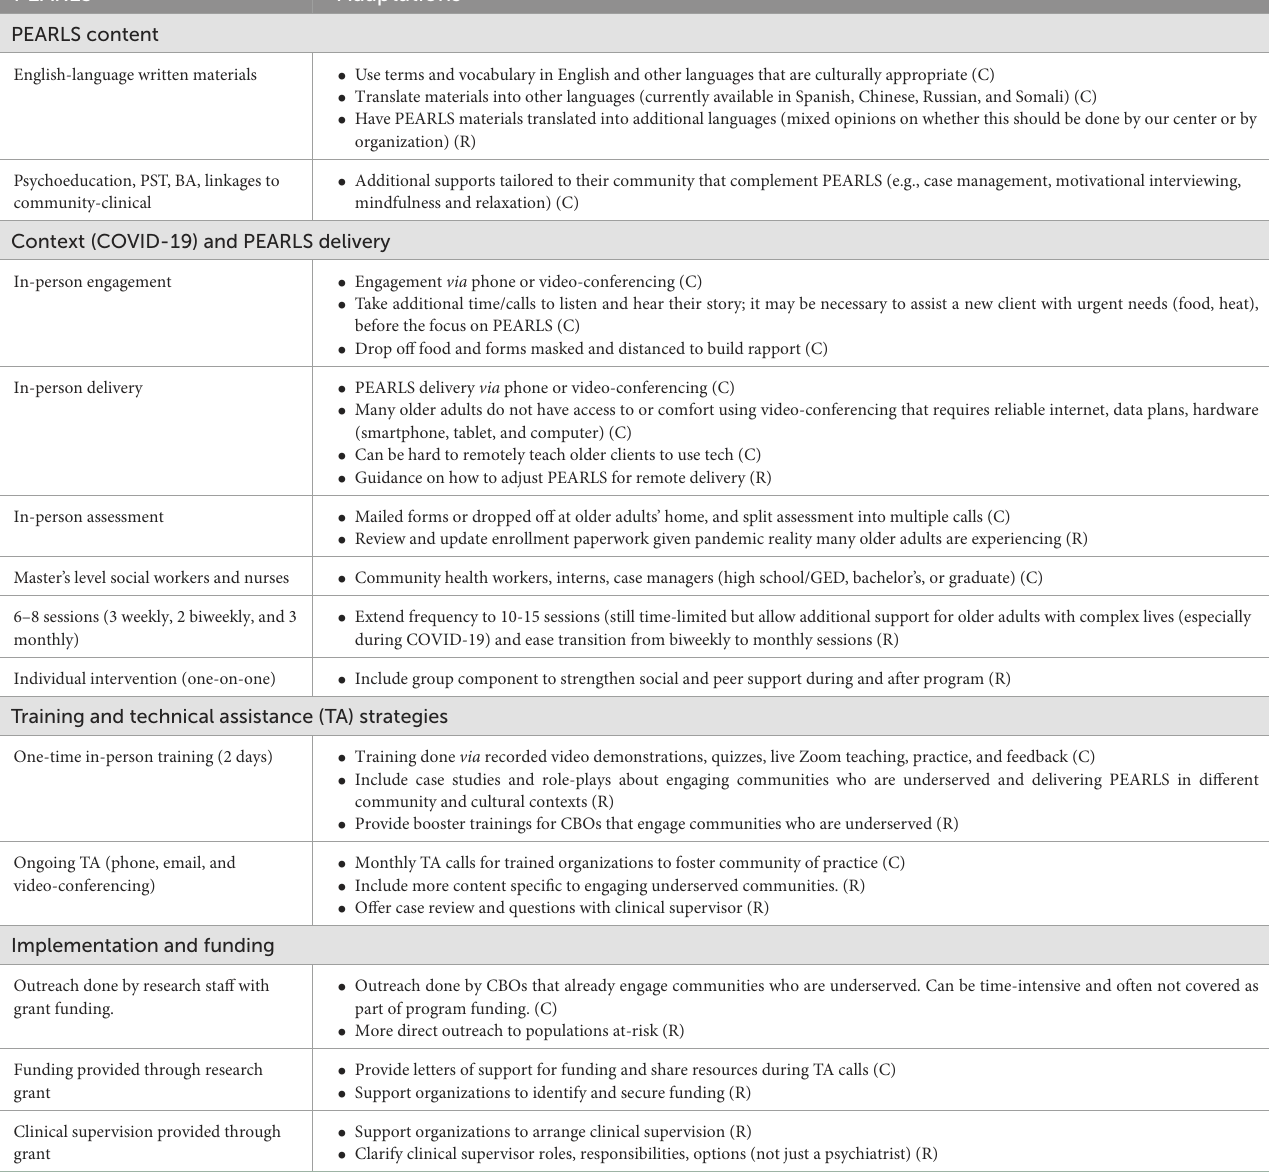
TABLE 4 Current (C) and recommended (R) adaptations a to PEARLS to engage older adults who are underserved.